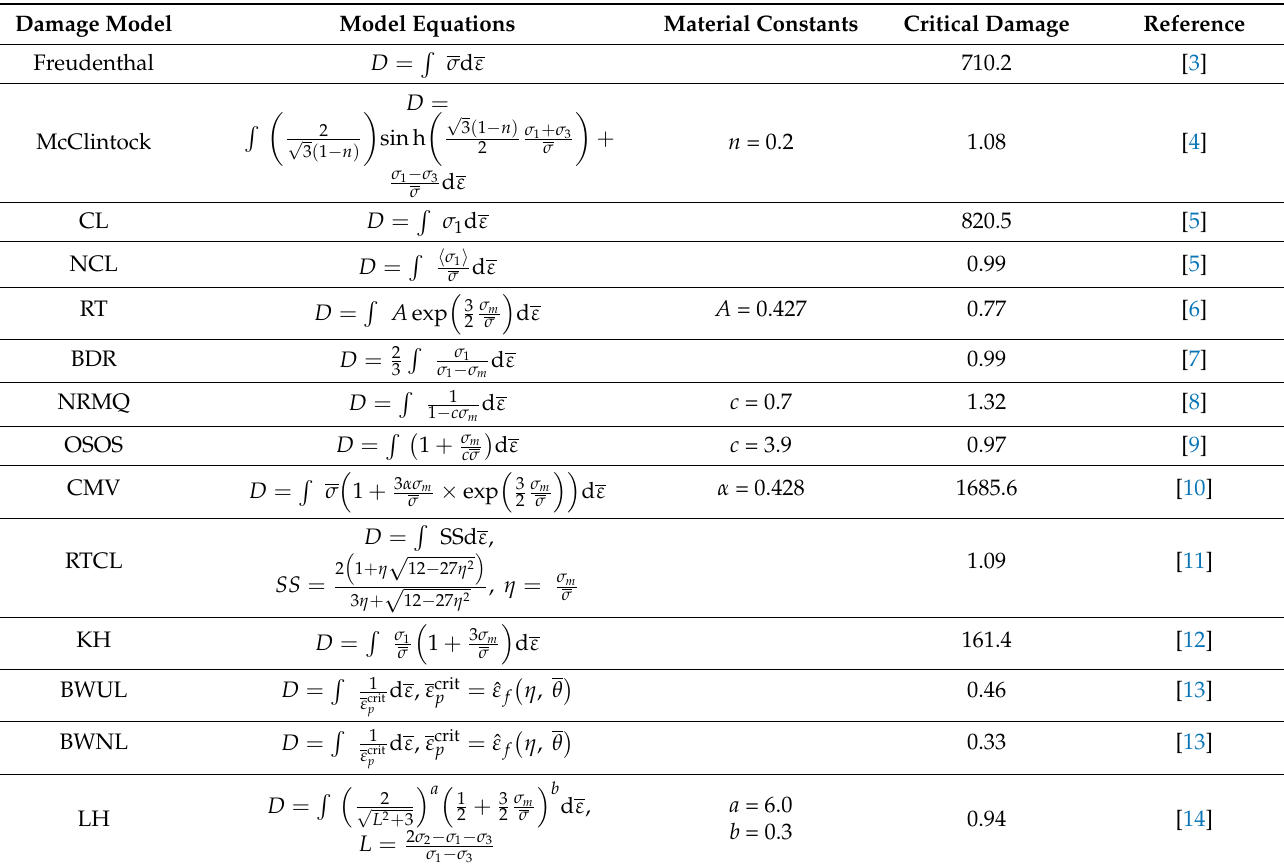
Table 1. Damage models employed in this study and their material constants. Damage Model Model